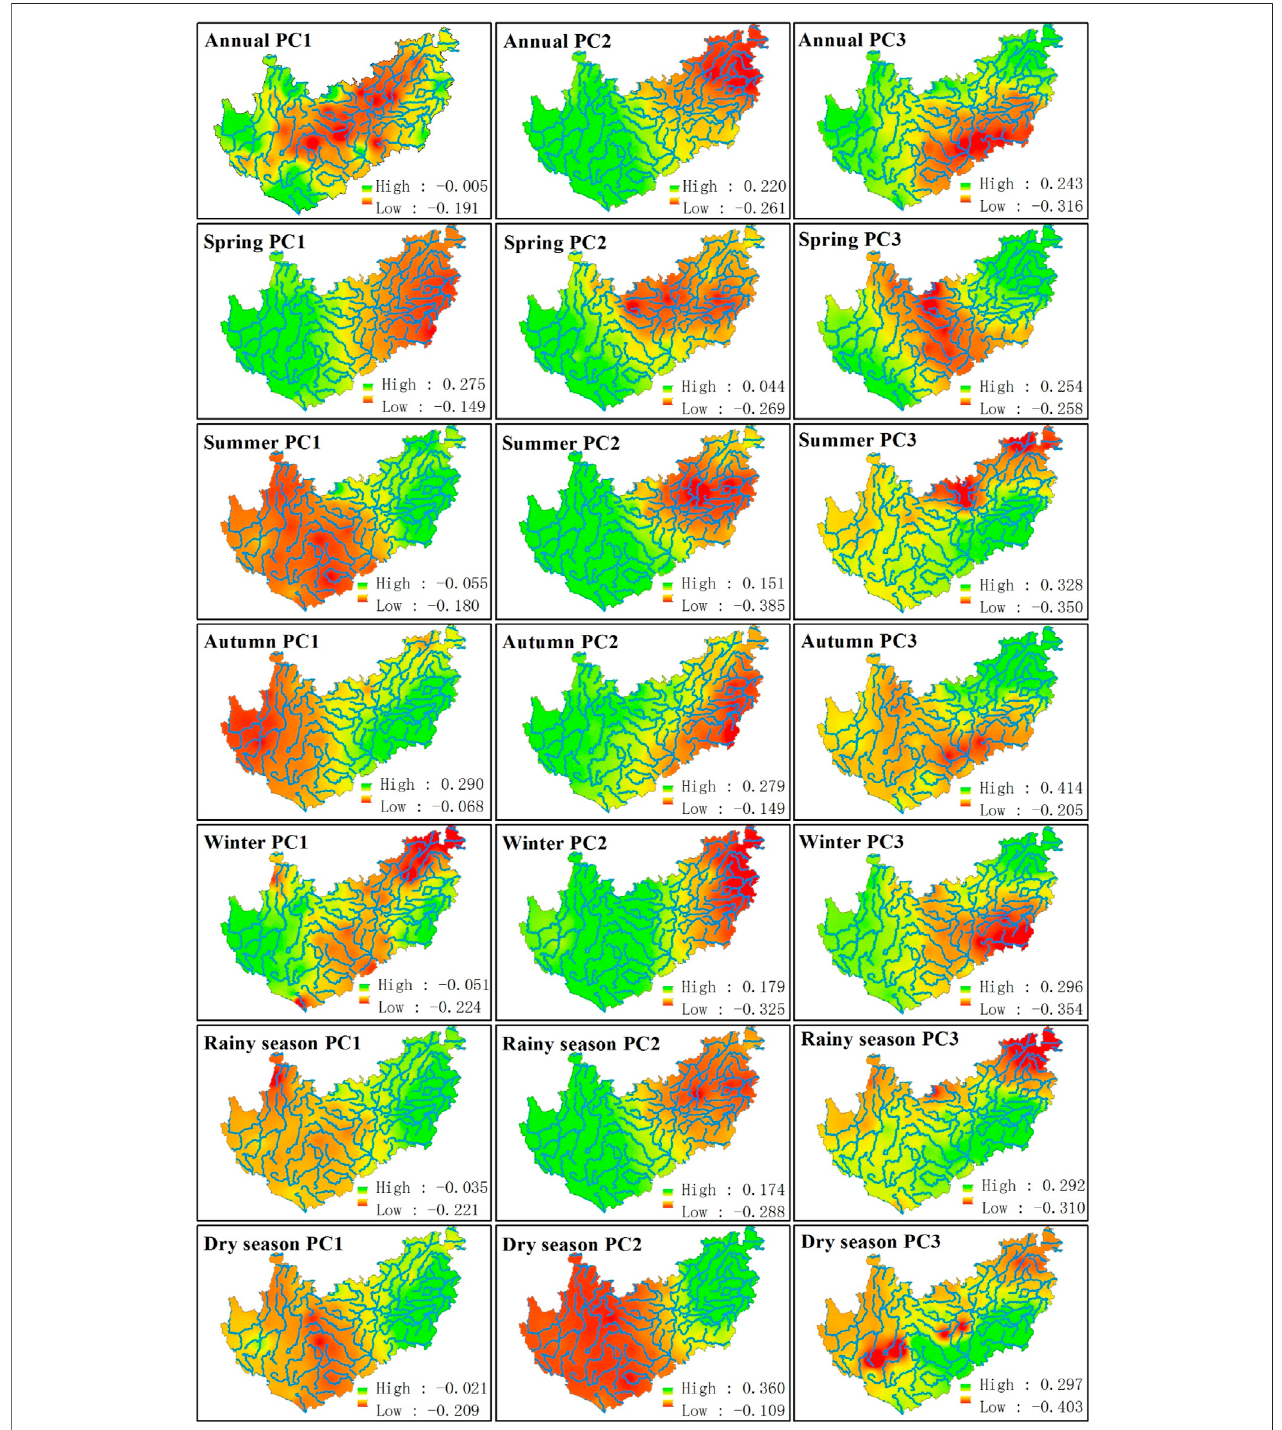
FIGURE 6 | Distribution of the fi rst three principal components of the SPEI annually and in different seasons.